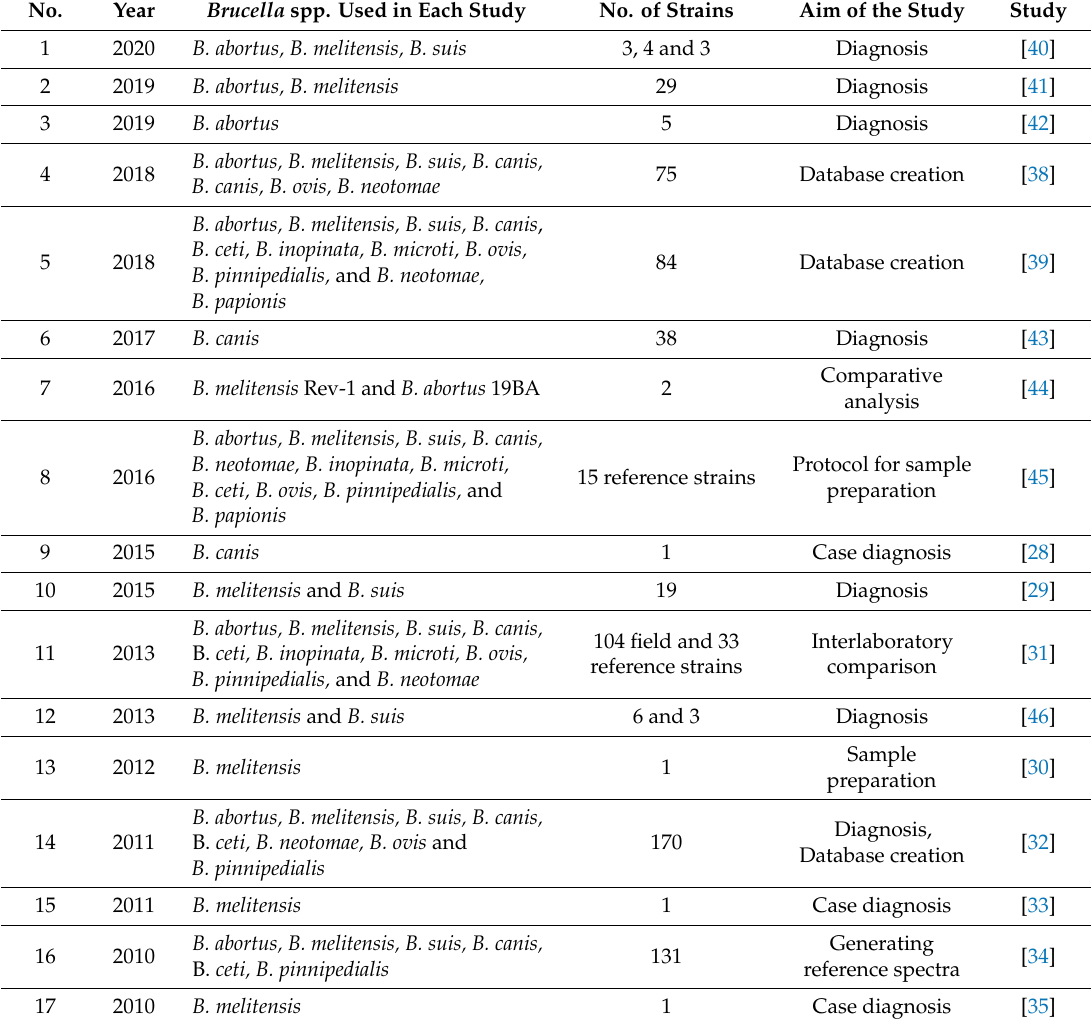
Table 1. Listofstudiesutilizingmatrix-assistedlaserdesorptionionization—timeofflightmassspectrometry (MALDI—TOF MS) for the direct identification of brucellae. No. Year Brucella spp. Used in Each Study No. of Strains Aim of the